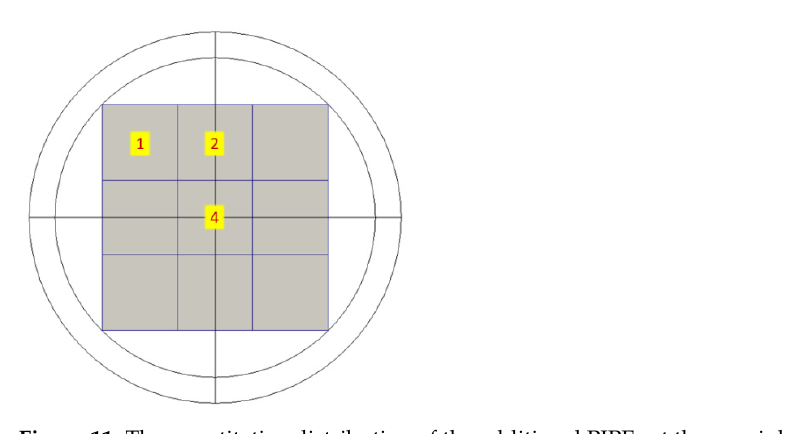
plane. Figure 11 illustrates the quantitative distribution of the additional PIPEs from the point of the CA-V (1 × 4 + 2 × 4 + 4 × 1 = 16). Figure 10. Nodalization of the CY-V ( left ) and the CA-V ( right ). Four FILL and BREAK components are connected to a portion of the cold and hot legs to define the boundary conditions of the problem, e.g., loops mass flow rate, coolant temperature, and pressure. The coolant enters the cold legs, then flows into the down- comer of the RPV and from there to the lower plenum where the flow changes direction and flows upwards entering into the core bottom. The coolant flows through the core and enters the upper plenum. Finally, it exits the RPV and flows into the BREAKs through the hot legs. The core is modeled by the Cartesian VESSEL, which is connected to the RPV- axial face Nr. 2 (core inlet) and the axial face Nr. 11 (core outlet). Hence, the core region in Once the code is launched, the steps listed under Section 3.2.1 are performed sequentially.